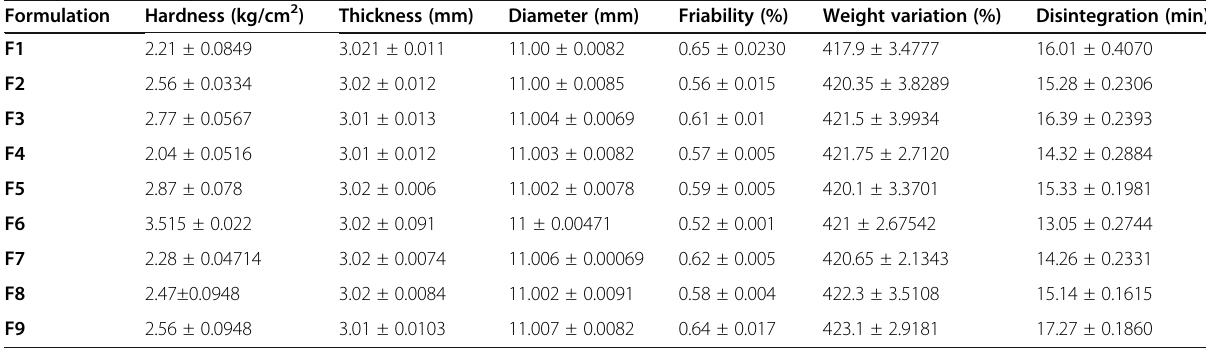
Table 7 Post-compression study data